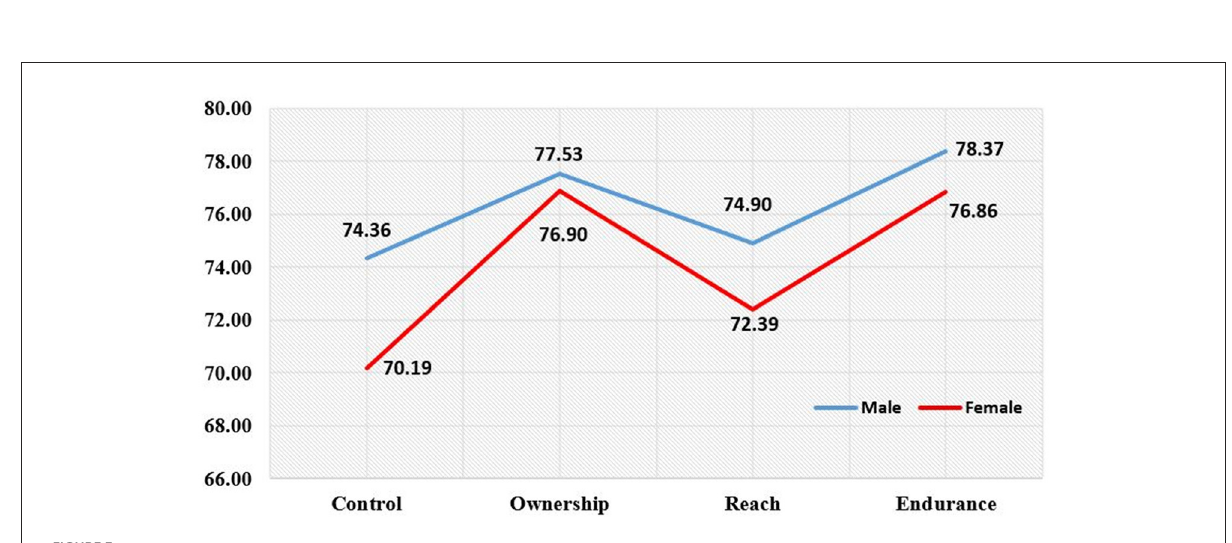
FIGURE3 AQ index by construct based on